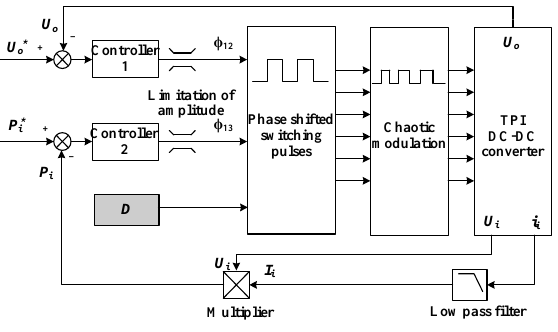
Figure 13. Block diagram of chaotic modulation based control for TPI bidirectional DC/DC converter.